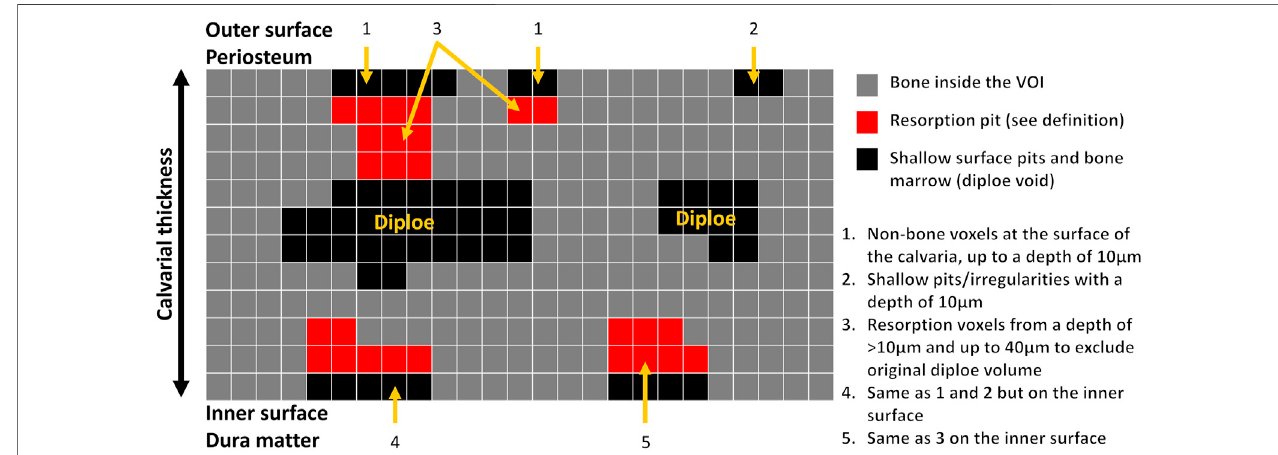
FIGURE 1 | Schematic representation of image processing and quantitation of the pit resorption volume in the mouse calvaria using µCT. Note that the calvarial thickness measurement in the volume of interest (VOI) is independent of the bone marrow and pit resorption volume.